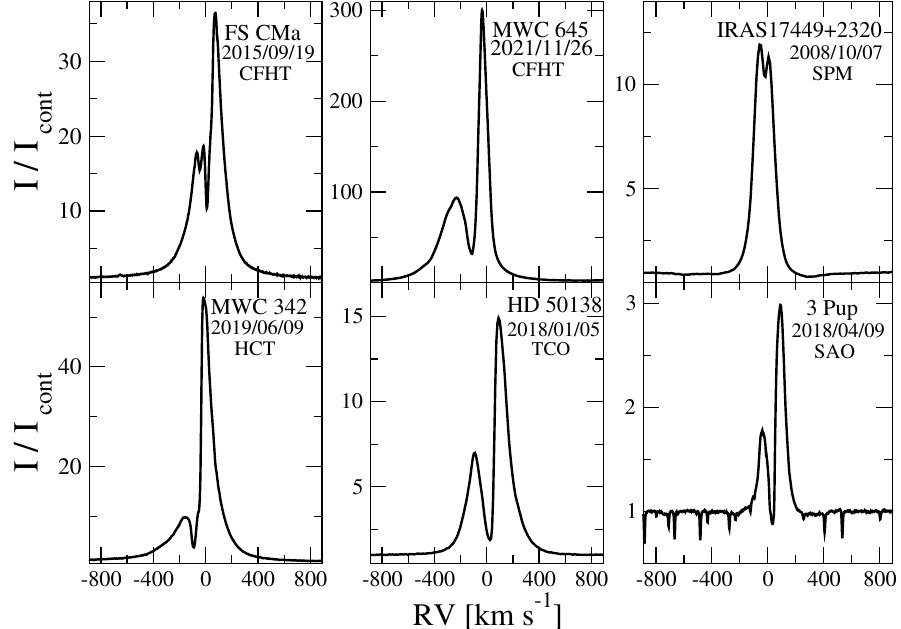
Figure 1. Selection of H α profiles of some FSCMa group objects with strong emission-line spectra. Objects’ names, observing dates, and the observatory ID are shown in each panel. Intensity is normalized to the local continuum, and heliocentric RV scale is shown in kms − 1 .